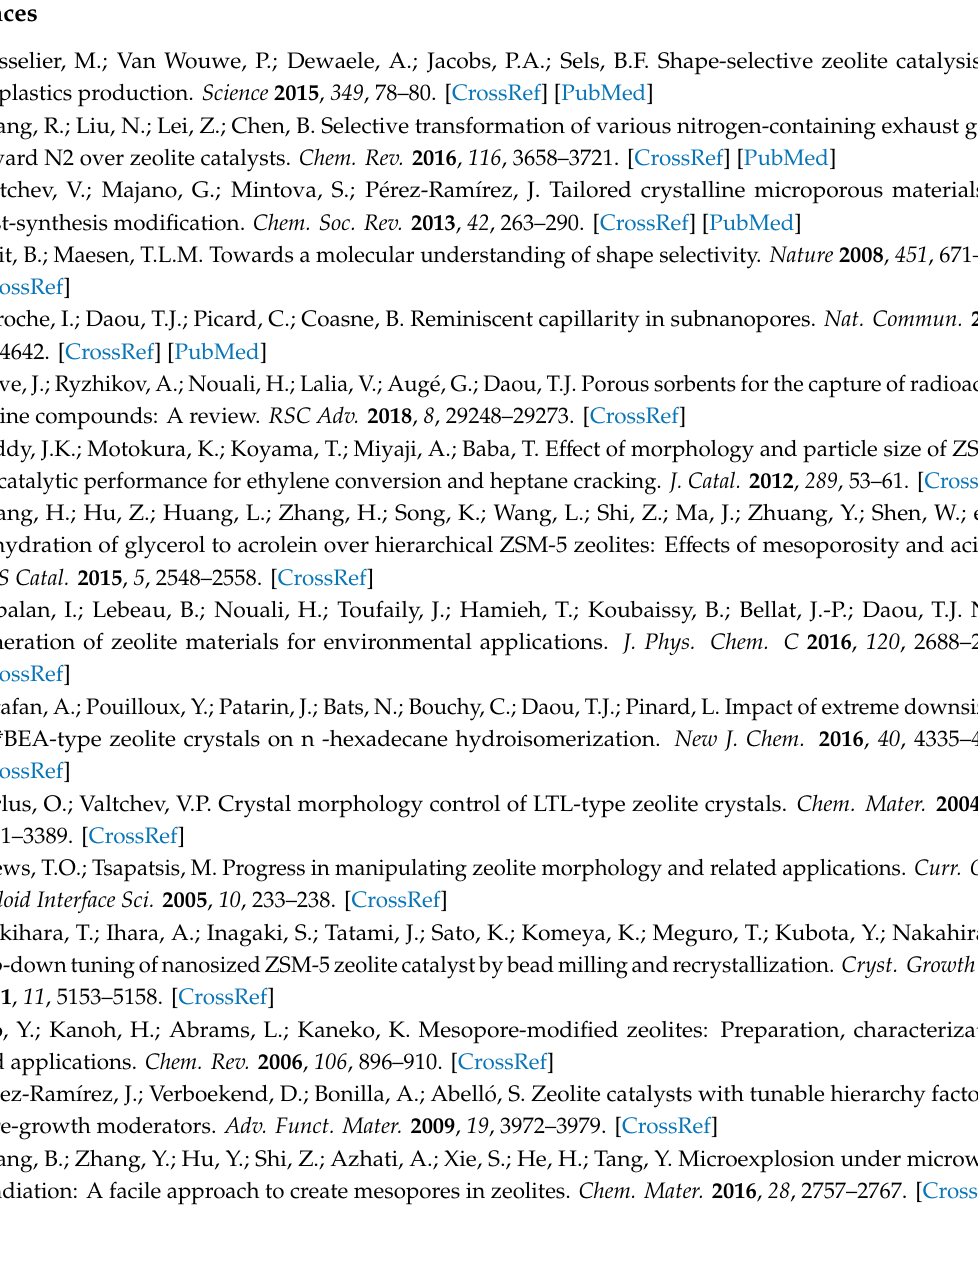
Figure S1. Scanning electron microscopy (SEM) images of the parent amorphous 20 µ m silica spheres. An average size of 23 ± 3 µ m was determined from measurements on about 100 beads, Figure S2. ( a ) Nitrogen sorption isotherm at 77 K and ( b ) DFT pore size distribution determined from the adsorption branch of the N 2 isotherm for the parent amorphous silica